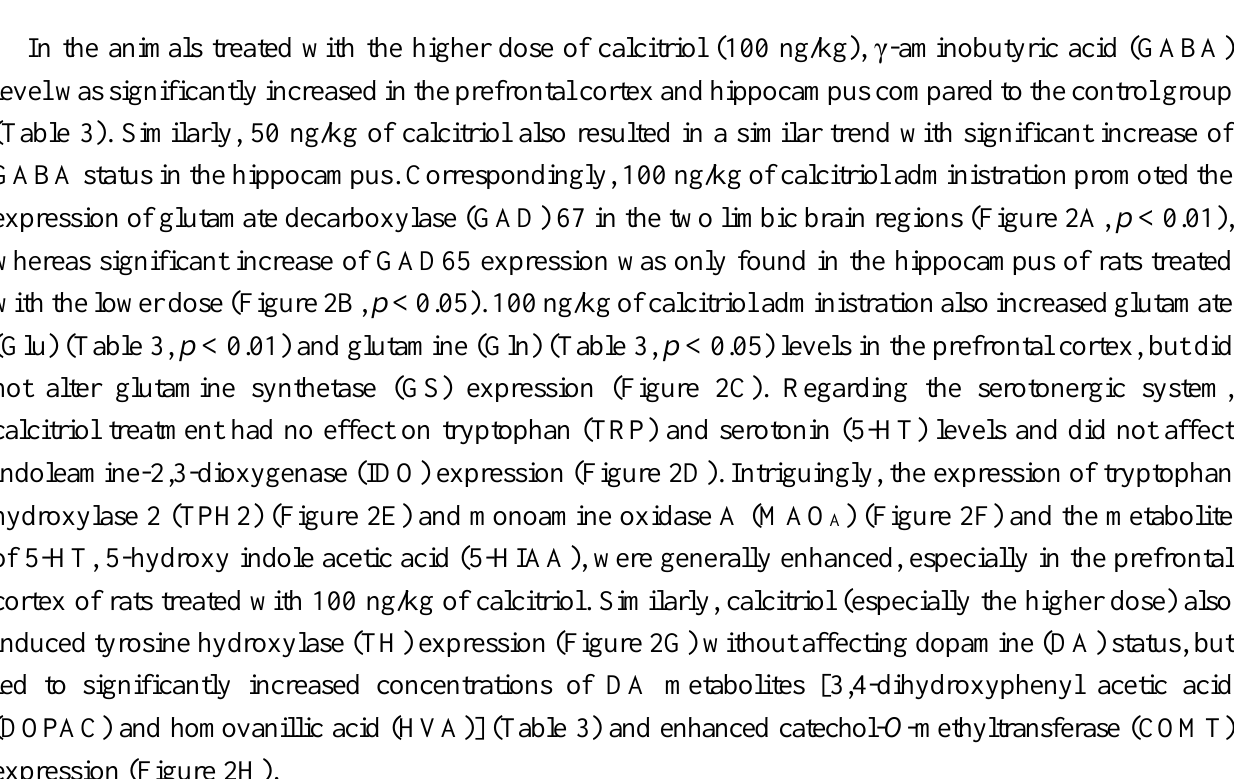
Table 3. The content of major neurotransmitters and their metabolites in the prefrontal cortex and hippocampus of rats following 6-week administration of calcitriol. Data